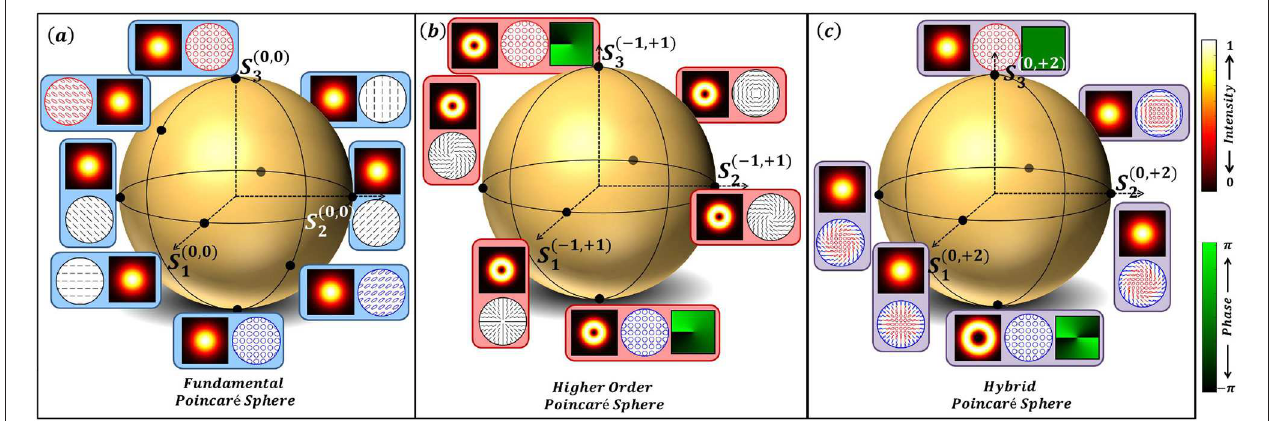
FIGURE 1 | (a) Fundamental Poincaré sphere, (b) Higher order Poincaré sphere (HOPS). (c) Hybrid order Poincaré sphere (HyOPS). In each sphere, the superscripts in the coordinate axes S 1 , S 2 , and S 3 denote the content of orbital angular momentum in the right (R) and left circular polarization (LCP) eigen states, respectively. Beam with constant ellipticity and varying azimuth across the beam cross-section can be represented by a point on the HOPS. HyOPS is used to represent beams with varying azimuth and ellipticity. In a Poincaré sphere Poles represent plane waves in RCP and LCP whereas in HOPS the Poles represent vortex beams of same magnitude with opposite sign. In a HyOPS, Poles denote vortex beams of different charges. All the non-polar points are obtained by superposition in the corresponding circular basis